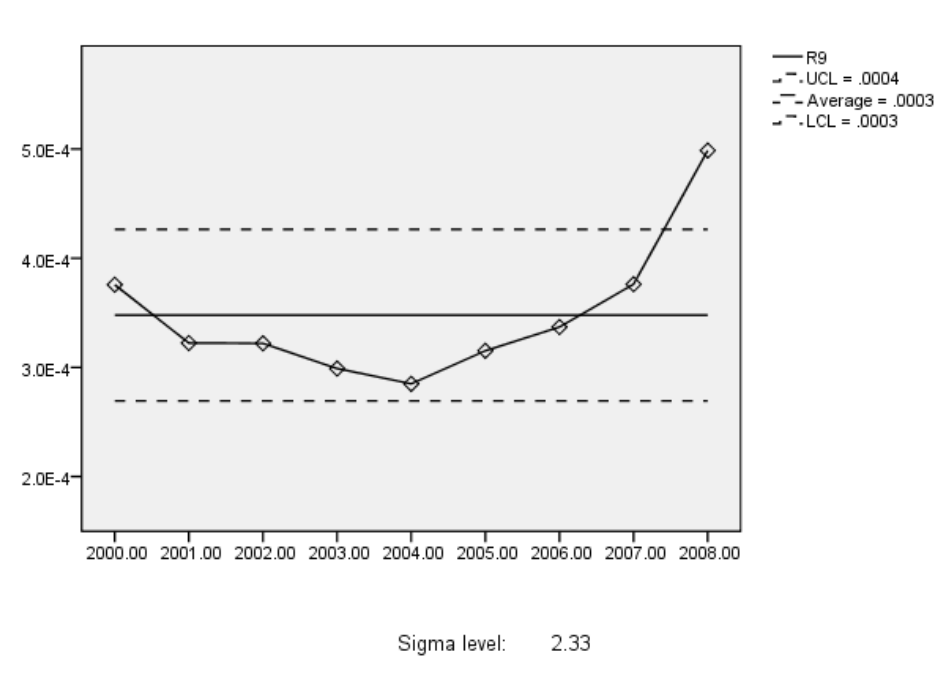
Figure 2. R(9) control chart for the Philippines.